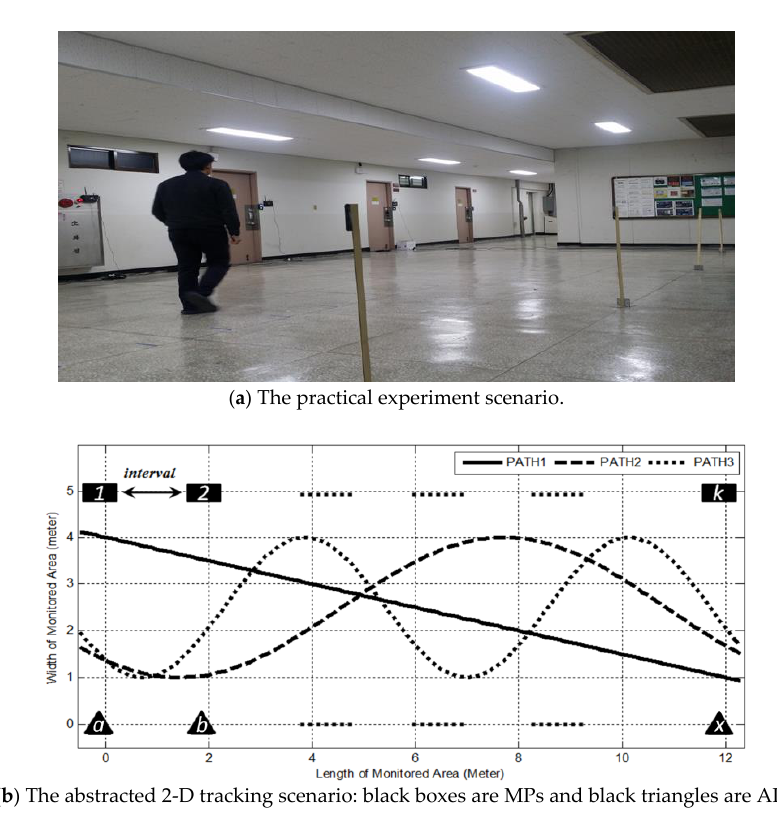
Figure 8. The experimental sketch to explore the effects of AP-MP density and trajectory sinuosity on the GF tracking scheme.